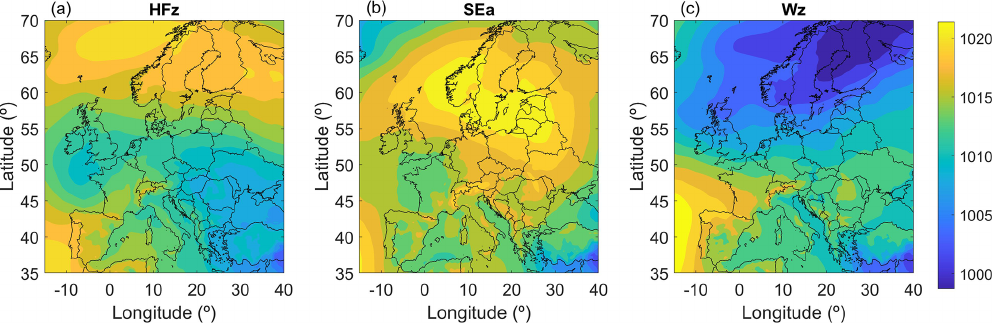
Figure 14. Weather patterns favorable for NLLJ development. Shown are composites of the 00:00UTC mean sea level pressure patterns during FESST@home for the weather patterns: (a) Scandinavian high , trough central Europe (HFz), (b) anticyclonic south-easterly (SEa) and (c) cyclonic westerly (Wz). The mean sea level pressure data were obtained from ERA5 reanalysis (Hersbach et al.,